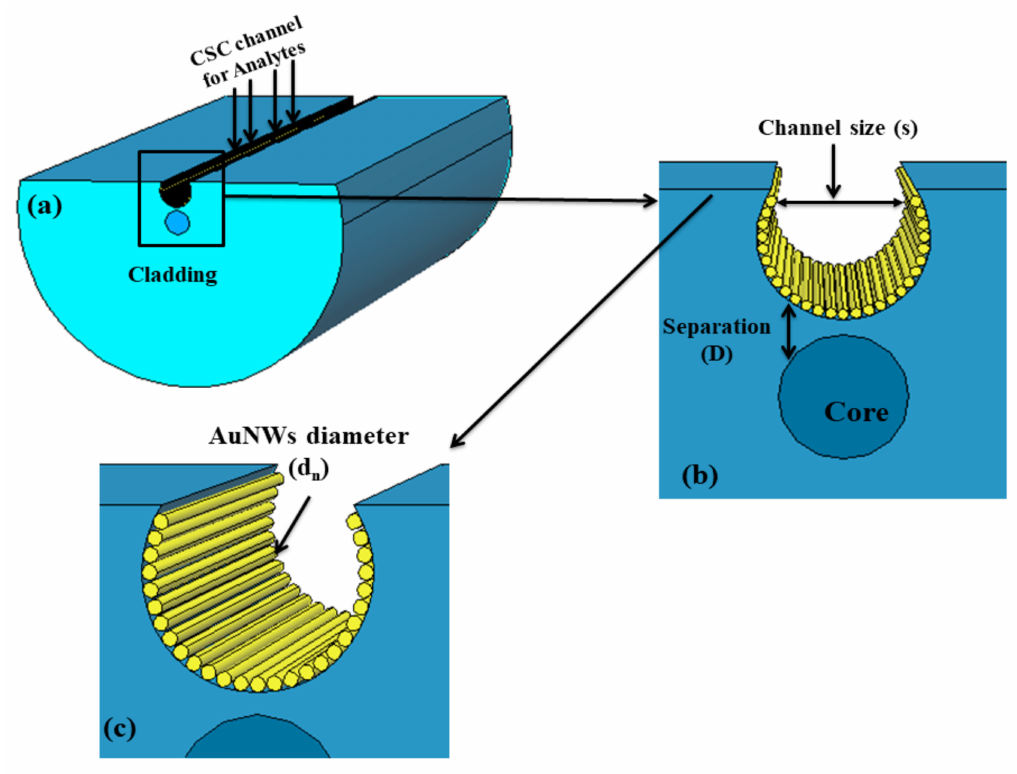
Figure 1. Schematic diagram of the designed concave shaped refractive index sensor (CSRIS) ( a ) cross section of designed sensor, ( b ) and ( c ) are the zoomed in and further magnified diagram of gold nanowires (AuNWs) covered concave shaped channel (CSC),